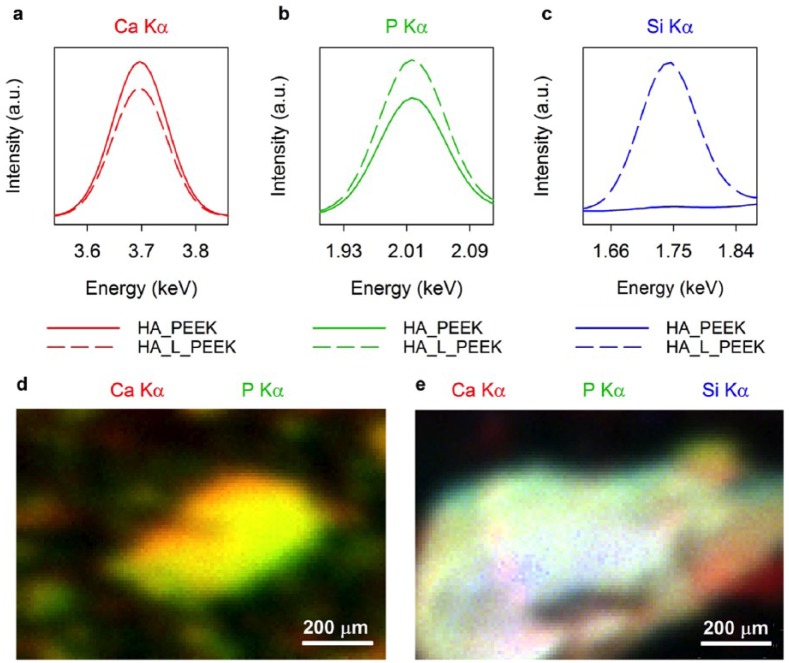
µ-XRF elemental mapping of HA particulates within HA_PEEK and HA_L_PEEK materials following fabrication. (a) µ-XRF spectrum central to the Ca Kα signal. (b) µ-XRF spectrum central to the P Kα signal. (c) µ-XRF spectrum central to the Si Kα signal. (d) Elemental map for a fracture surface of HA_PEEK with Ca and P Kα channels shown. (e) Elemental map for a fracture surface of HA_L_PEEK with Ca, P and Si Kα channels shown.